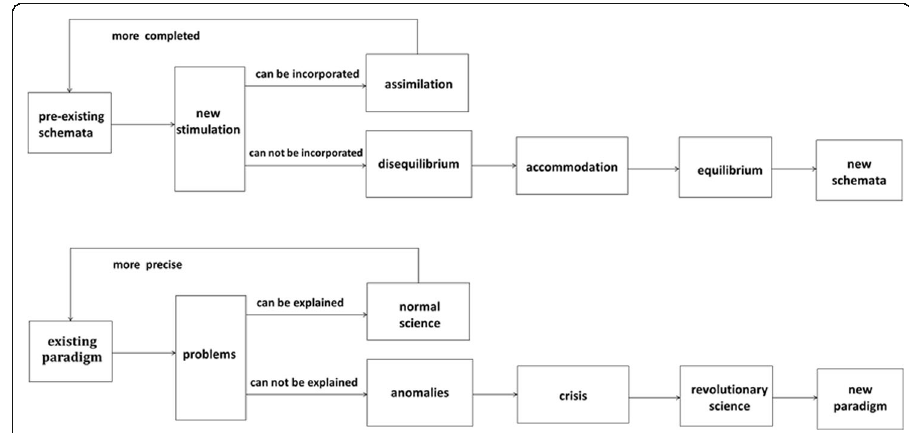
Fig. 5 Comparison of the patterns of the theories of J. Piaget and T. Kuhn (Shi